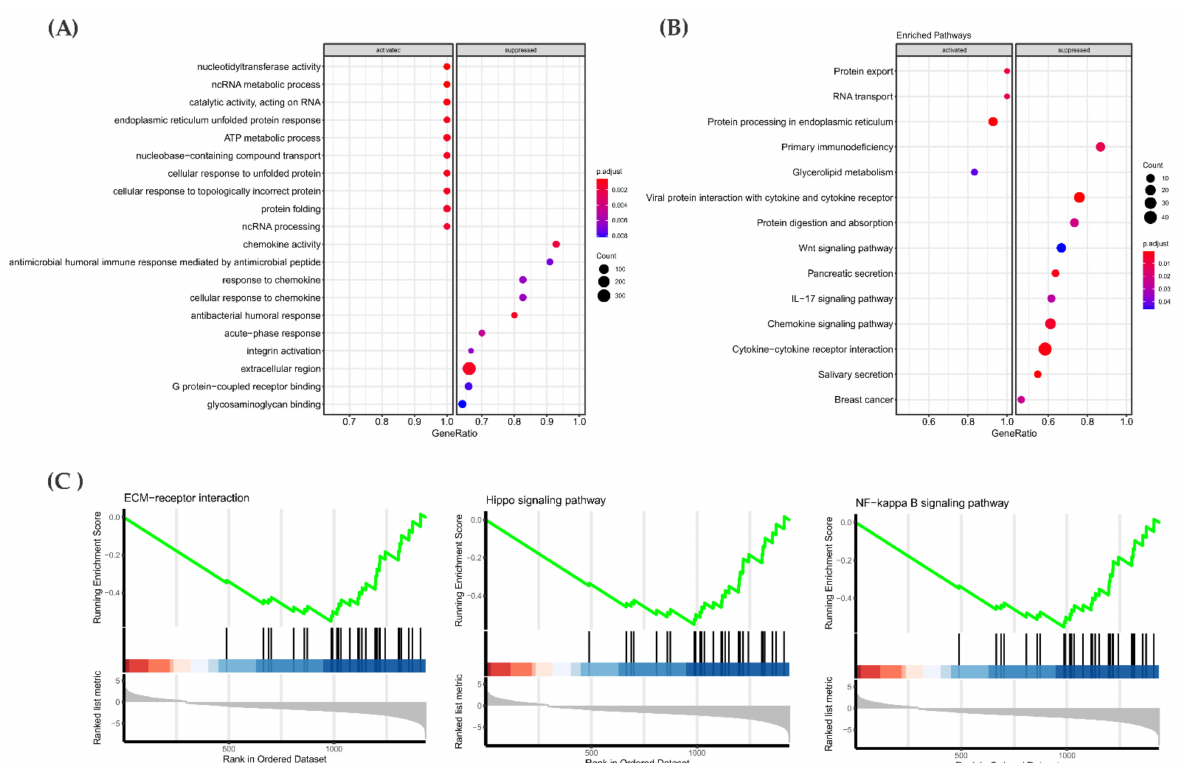
Figure 6. Differential gene expression analysis in RAS -positive PTC samples from the TCGA cohort (60 samples). Enrichment analysis (GSEA and KEGG) was performed on the top 10% genes differentially expressed composing the ones with lowest adjusted p -values to gain insights into altered biological process and pathways. ( A ) GSEA enrichment analysis of the biological processes that contain upregulated genes are marked on the left panel and downregulated on the right panel. ( B ) Pathway enrichment analysis result showed pathways in which most of their genes are upregulated (left) or downregulated (right) in RAS -positive TCGA cohorts. ( C ) Common pathways associated with cancer progression differentially expressed in both RAS -positive discovery cohort and RAS -positive PTC from the TCGA